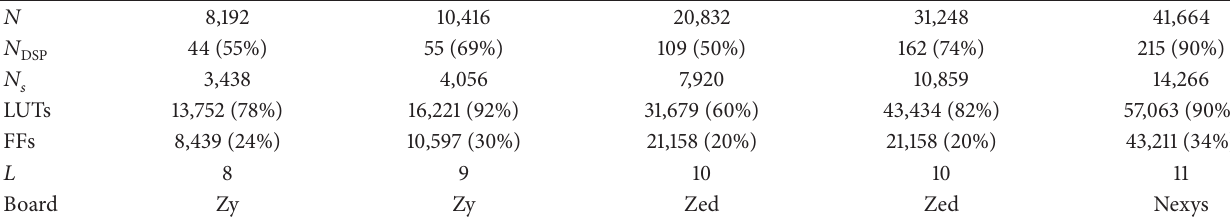
Table 1: The results of experiments ( 𝜂 = 32